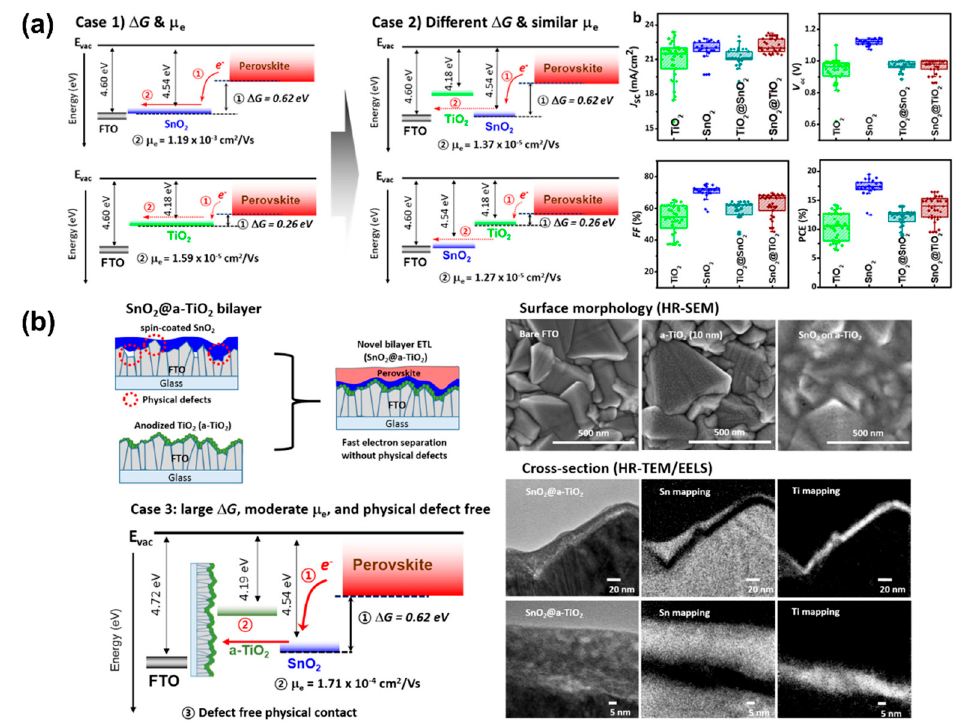
Figure 6. ( a ) Illustration and J-V characteristics of different Gibbs free energy and electron mobilities; SnO 2 , TiO 2 , SnO 2 @TiO 2 , and TiO 2 @SnO 2 . ( b ) Illustration and SEM image of SnO 2 on anodized TiO 2 layer. Reprint with permission [85]; 2017, American Chemical Society.